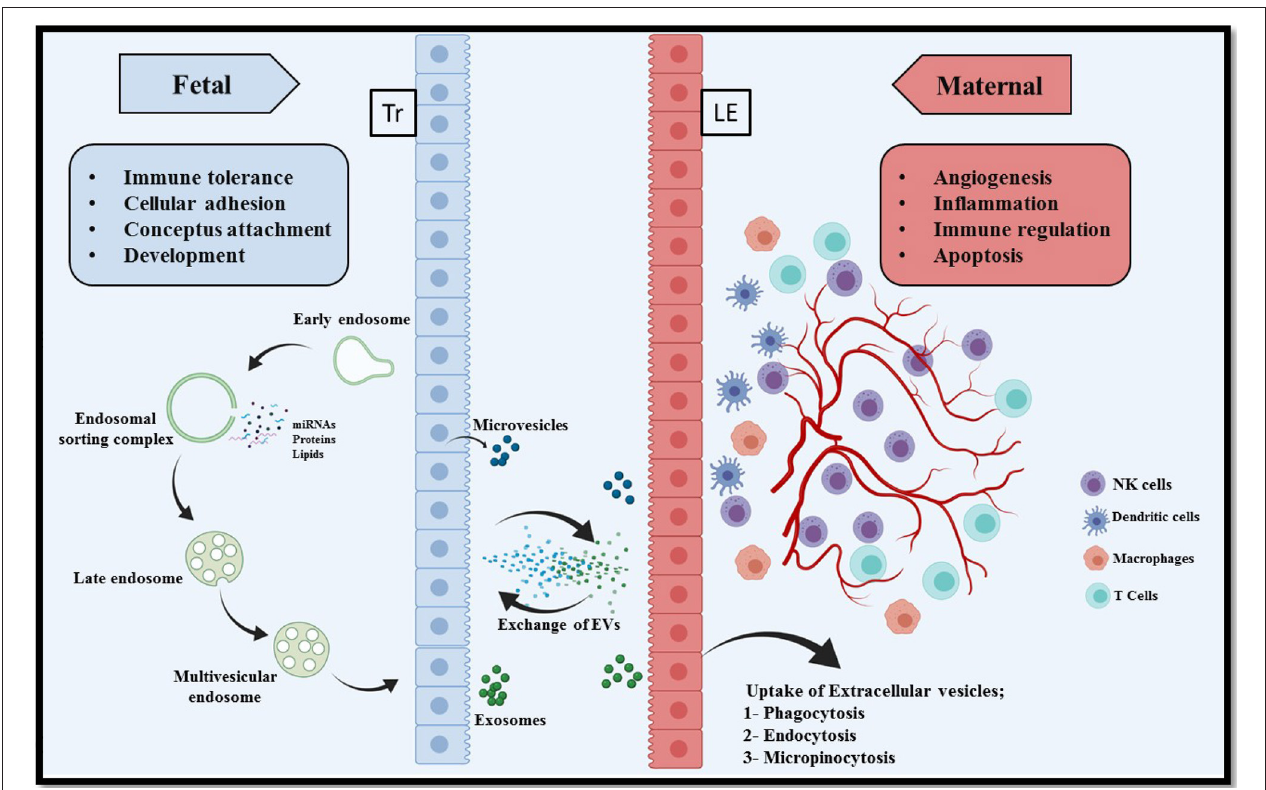
FIGURE 1 | Extracellular vesicle mediated bi-directional communication at the porcine maternal fetal interface. In epitheliochorial placentation in pigs, fetal trophoblasts (Tr) lay in simple apposition with maternal endometrial luminal epithelium (LE). Extracellular vesicles comprising microvesicles and exosomes are a heterogeneous group of cell-derived membranous structures originated from either endosomal system (microvesicles) or shed from the plasma membranes (exosomes). The unique cargo of these EVs contain biomolecules (nucleic acid, proteins, and lipids). These EVs can be internalized by multiple pathways including phagocytosis, endocytosis, pinocytosis, or can remain bound to the cell surface depending on the cell type. Interaction of EVs with recipient cells modulate several critical pregnancy associated processes, for example, conceptus attachment, development, immune tolerance on the fetal side and angiogenesis, inflammation, and apoptosis on the maternal